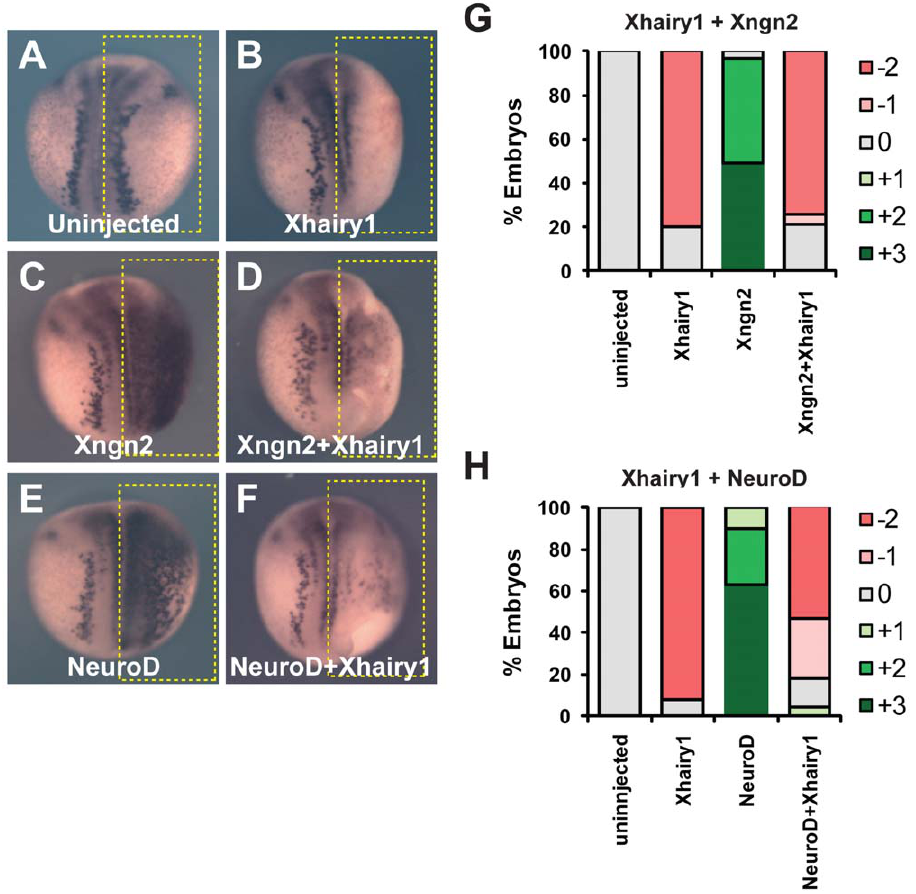
Figure 5. Xhairy1 inhibits the proneurogenic activity of Xngn2 and NeuroD. Embryos either uninjected (A) or with mRNAs encoding Xhairy1 (B), Xngn2 (C), Xhairy1 plus Xngn2 (D), NeuroD (E) or NeuroD plus Xhairy1 (F) injected into one cell at the two cell stage were analyzed for N- tubulin expression by in situ hybridization at neurula stage. G,H quantitation of phenotypes seen, scored as shown in Figure S2; Full data on the frequency of phenotypes and the number of embryos analyzed is given in Tables 3, 4, and 5.